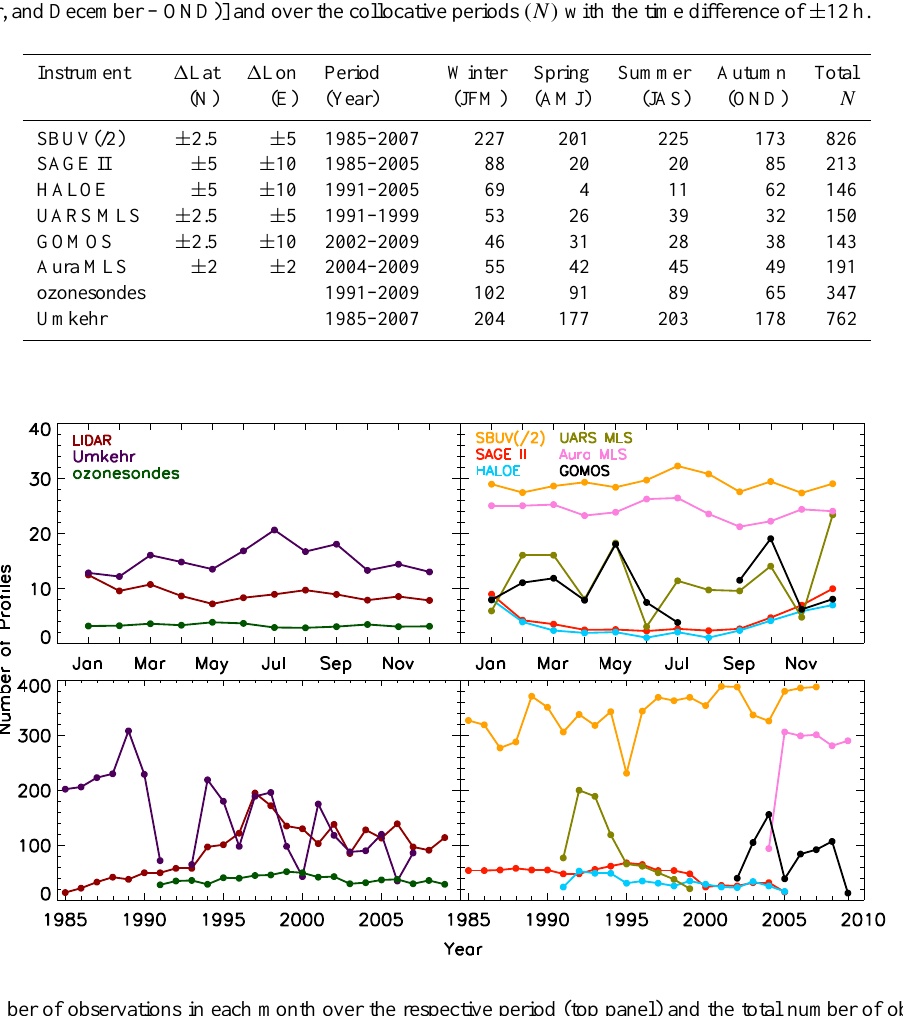
Table 1. Statistics of the comparison study: selection criteria in latitude (Lat) and longitude (Lon) applied for the satellite measurements